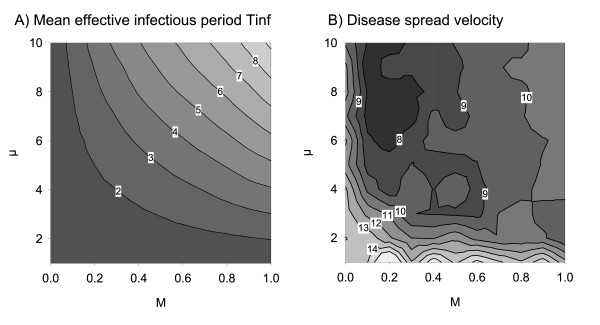
Isoclines of (A) mean effective infectious period Tinf [weeks], corresponding to parameter combinations M × μ and averaged over all infected animals. (B) Disease spread velocity [km/quarter].